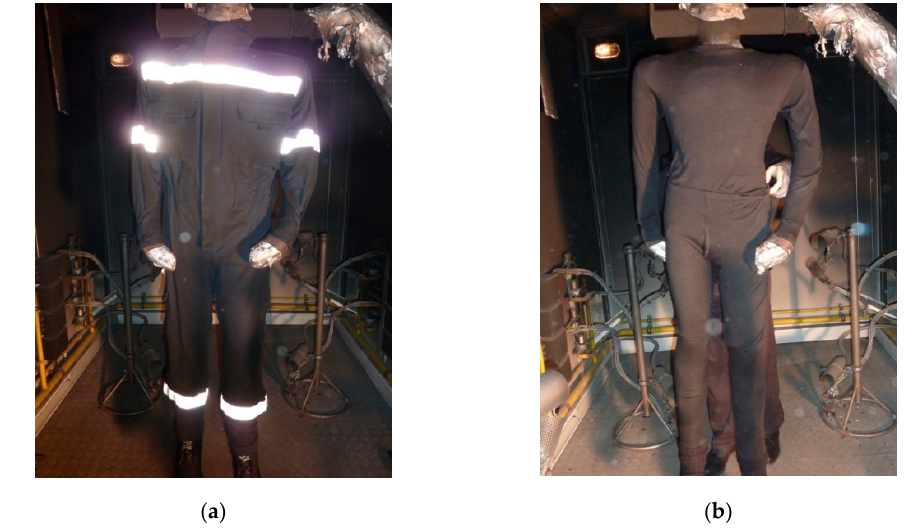
Figure 6. Parts of the clothing system after exposure to heat and flame: ( a ) overalls and ( b ) under- wear.